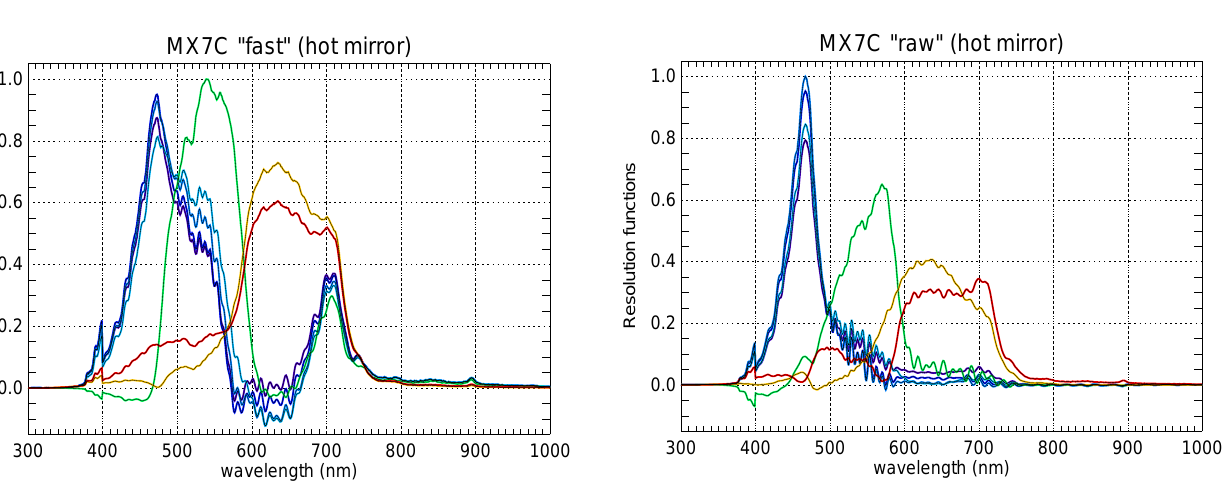
raw mode produces essentially the same blue, green, and red channels as before, but with the addition of a more distinct NIR channel. Backus–Gilbert analysis indicates that NIR fil- ter has important benefits for H9C and MX7C fast-mode data, but eliminates MX7C-raw information.